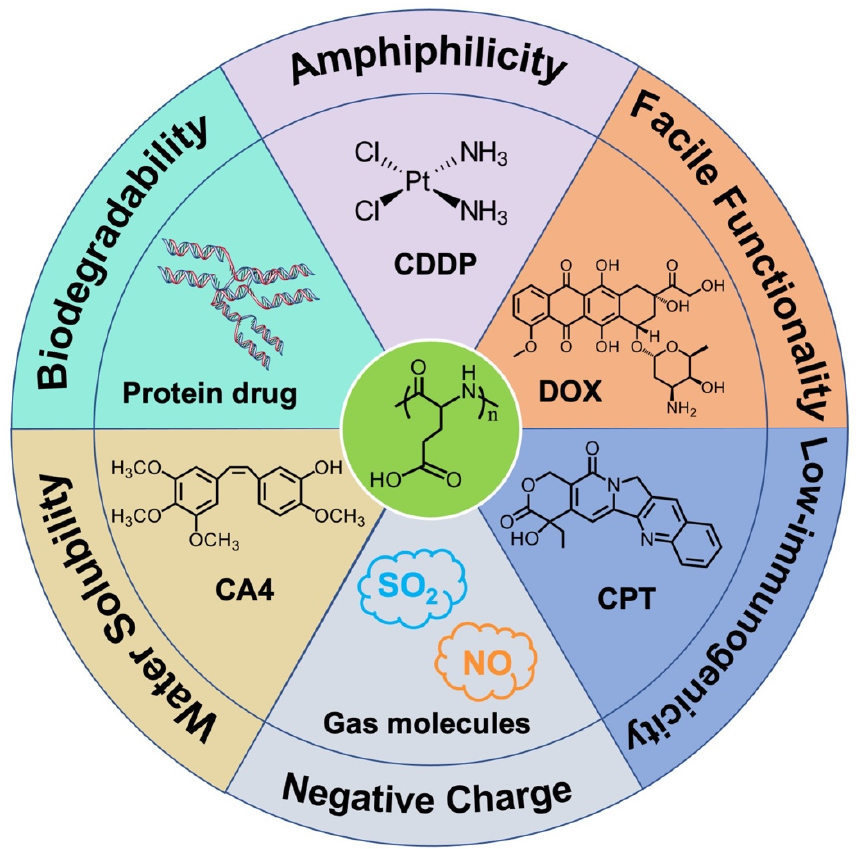
Figure 1. Schematic illustration of properties and the encapsulated drugs of PGA-based nanomateri-